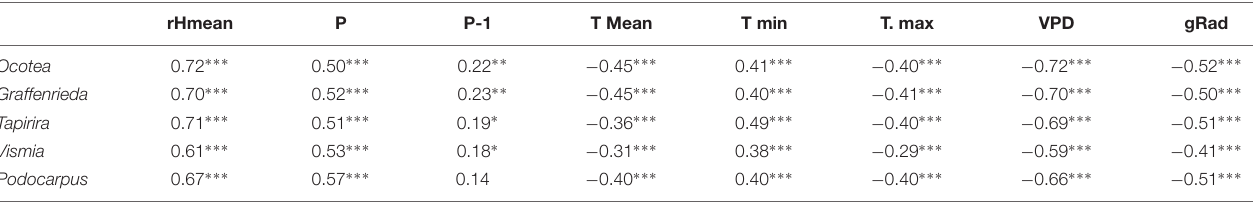
TABLE 2 | Correlations between daily circumference changes of different tree species with climate parameters. rHmean P P-1 T Mean T min T. max VPD gRad